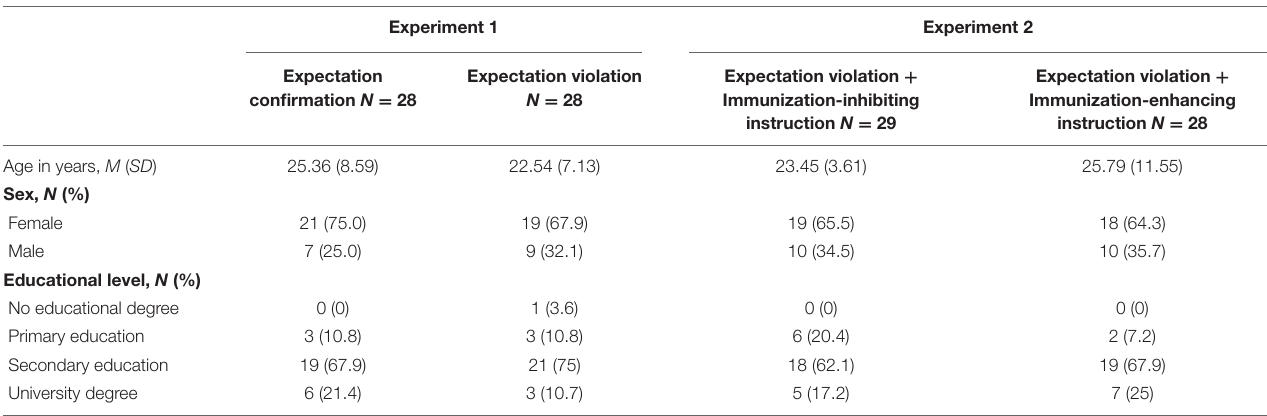
TABLE 1 | Sociodemographic characteristics of the sample ( N =